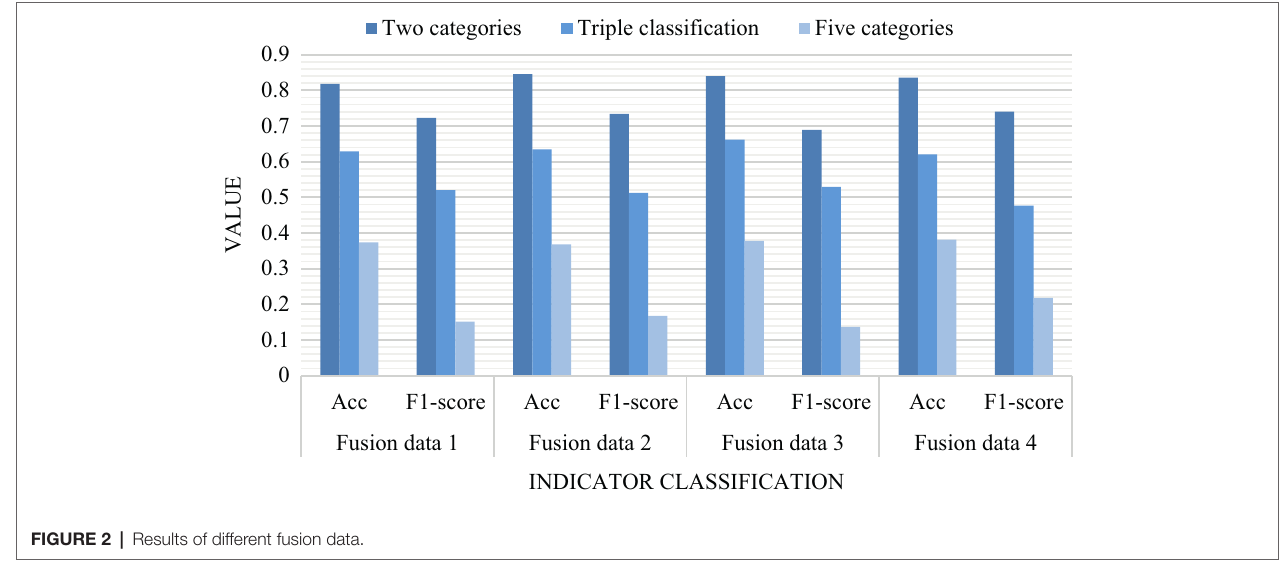
FIGURE 2 | Results of different fusion